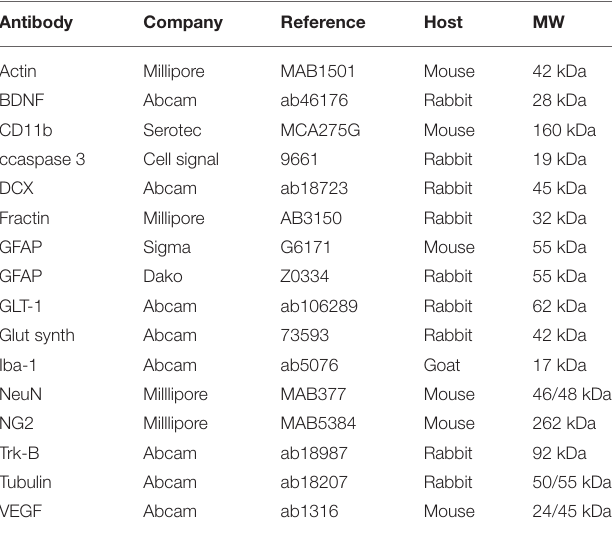
TABLE 1 | List of the antibodies